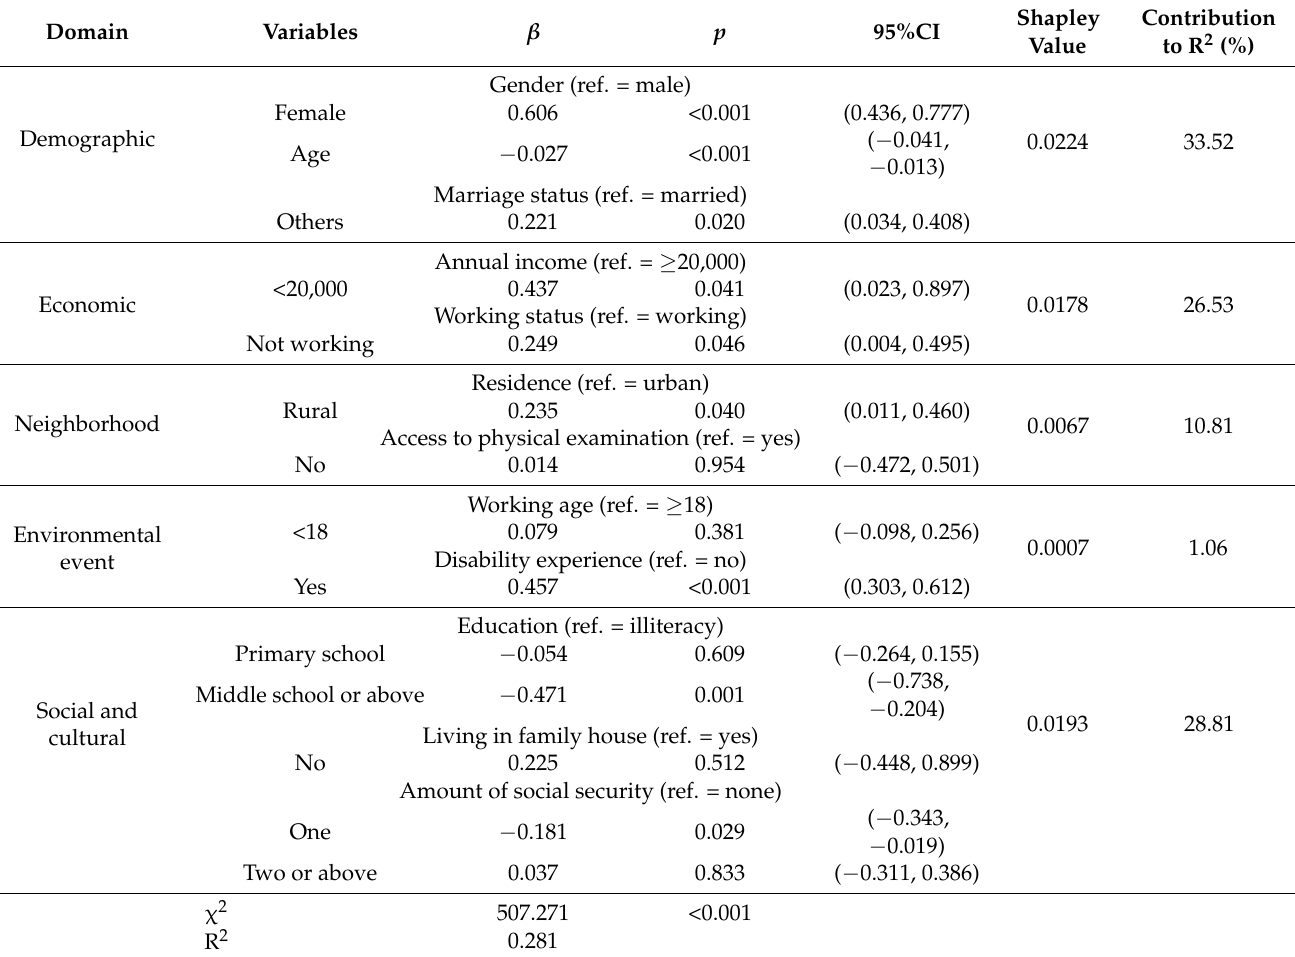
Table 2. Results from logistic regression and Shapley value regression ( n =